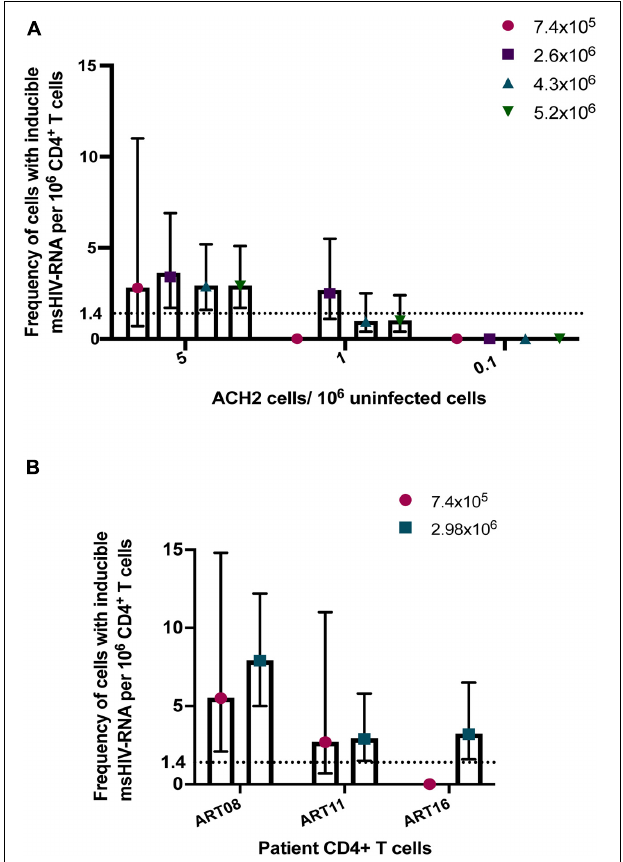
FIGURE 2 | Detection of tat/rev msRNA in low reservoir samples. (A) Target detection in three low concentrations of ACH-2 cells mixed with one million uninfected CD4 + T cells. The total number of cells tested per plate ranged from 7.4 × 10 5 cells to 5.2 × 10 6 cells (B) CD4 + T cells obtained from three ART-suppressed individuals (plasma HIV RNA < 20 c/mL) were stimulated with PMA/ionomycin for 12–14 h. The frequency of cells expressing tat/rev msRNA was determined using TILDA v2.0 (Lungu et al., 2020) with standard (7.4 × 10 5 cells) or higher cell inputs (colored symbols). The mean estimates of inducible cells/10 6 CD4 + T cells are plotted in both graphs. The error bars represent the 95% confidence interval upper and lower limits. The horizontal line represents the assay limit of detection (LOD) based on the standard cell input (7.4 × 10 5